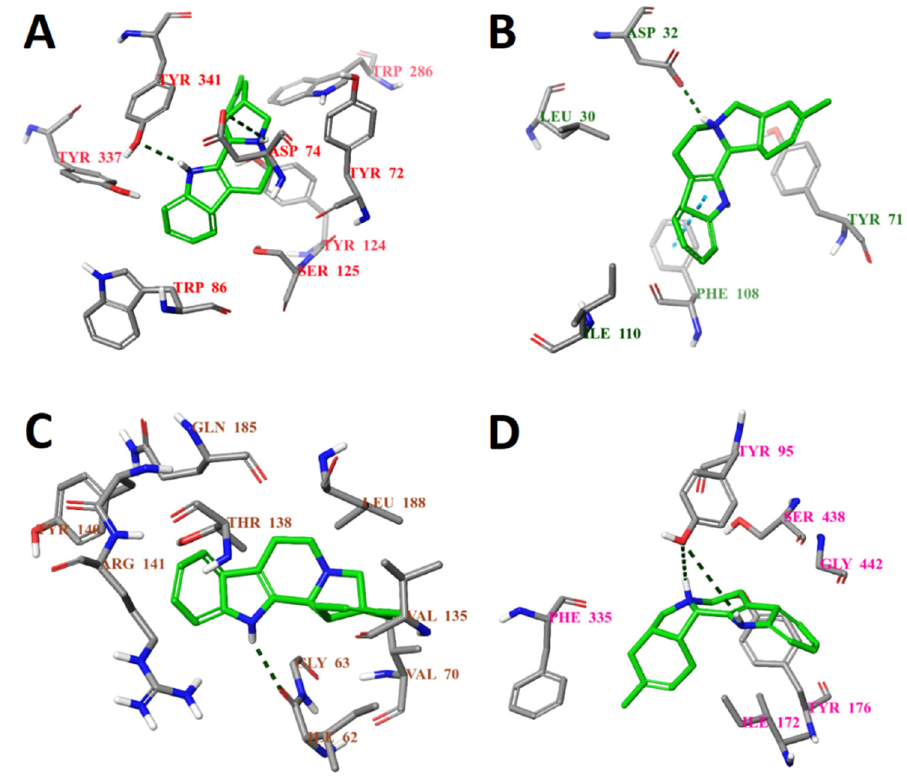
Figure 5. Calculated binding modes of compound ZINC4027357 ( A ) in the active site of AChE (ID: 4EY6); ( B ) in the active site of BACE1 (ID: 6EQM); ( C ) in the active site of GSK3 β (ID: 1PYX); ( D ) in the central active site of SERT (ID: 5I6X). The amino acid residues of target proteins are colored as gray (carbon), blue (nitrogen), red (oxygen), and white (hydrogen). Hydrogen bonds formed between compound and residues of target proteins are represented by green dashed lines, and pi–pi stacking is represented by a blue dashed line.